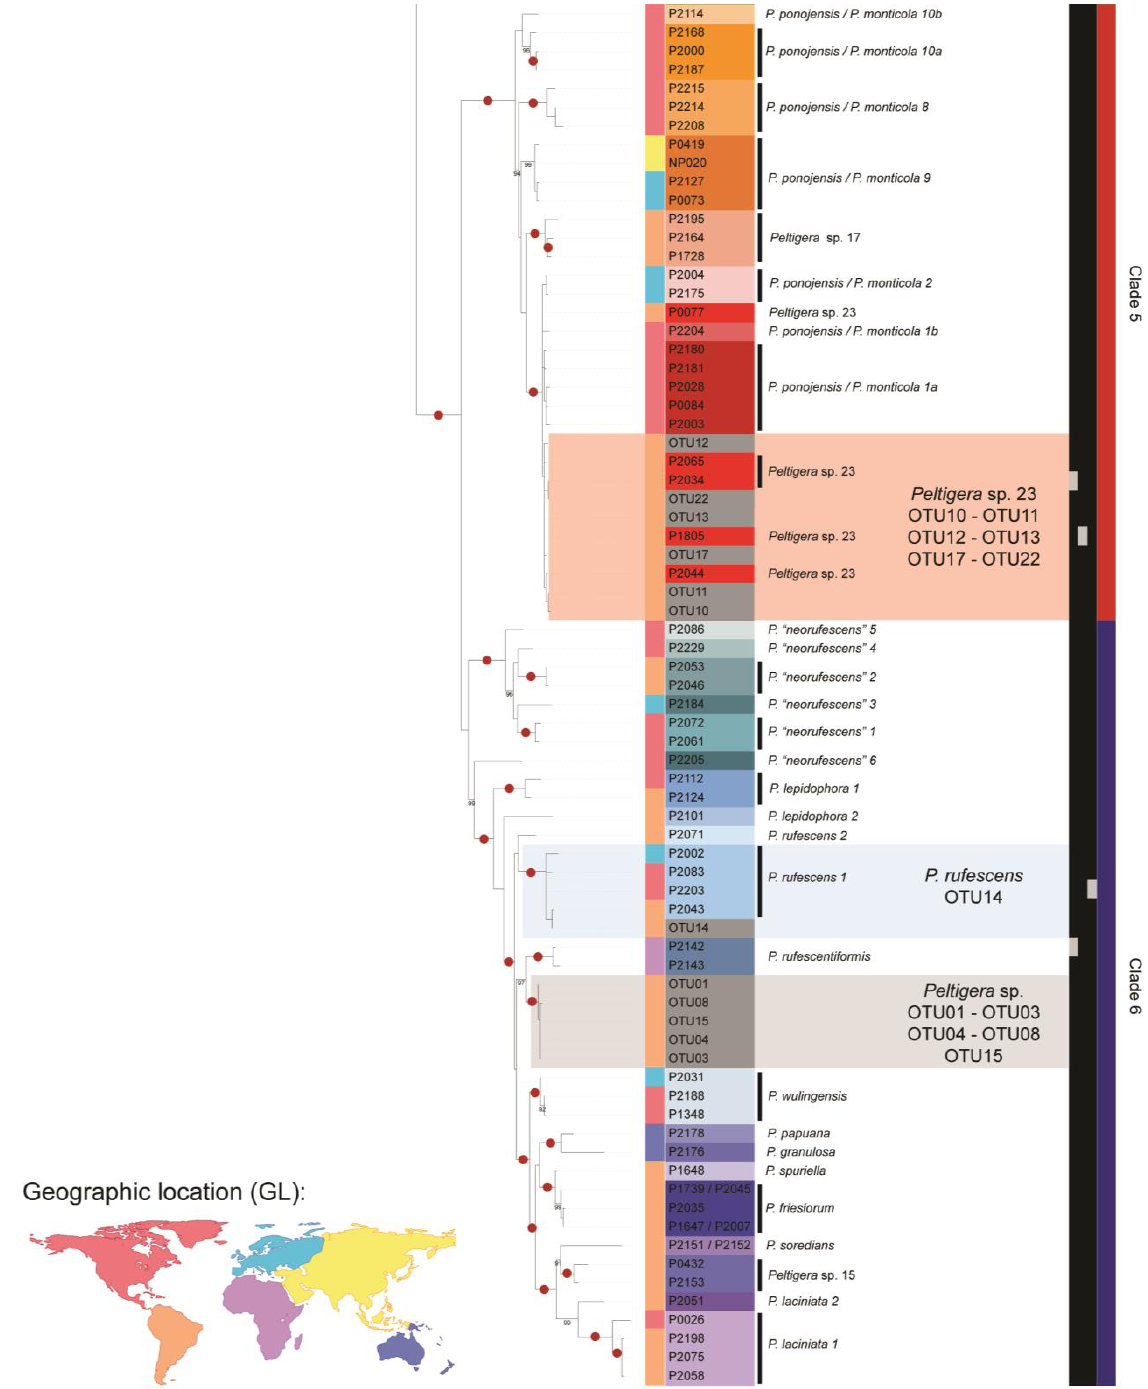
Figure 2. Peltigera best ML tree resulting from a RaxML analysis of a concatenated dataset of three loci representing 128 multi-locus reference sequences, 23 sample sequences and 2 outgroup sequences from section Retifoveatae . The label of each reference sequence is colored according to the species delimited by Magain et al. [13] or Miadlikowska and Magain (personal communication) [39], which are indicated next to the tree clusters. OTUs generated in this study are indicated in gray. Color boxes represent the geographical location (GL) from where the samples were collected, and black boxes represent the sequenced loci in the following order: β-tubulin (T), COR3 (C) and ITS (I). The clades in the tree are represented by a color bar numbered according to Magain et al. [13]. Bootstrap support ≥ 90% is indicated with numbers, and support of 100% is indicated with red circles.